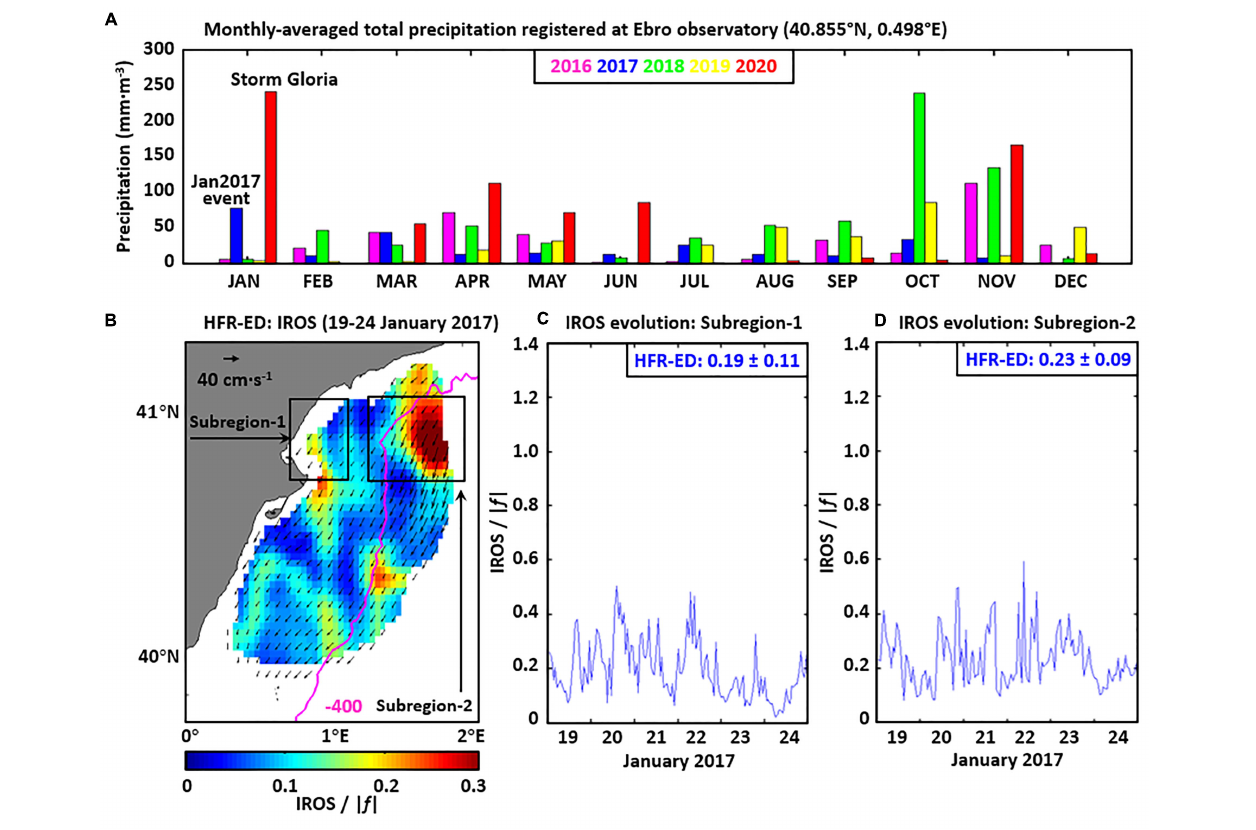
FIGURE 9 | (A) Monthly averaged precipitation registered at the Ebro observatory for the period 2016–2020; (B) Time-averaged map of circulation and Instantaneous Rate of Separation (IROS) for the 6-day period (January 19–24, 2017) as derived from HFR-ED hourly surface currents. (C,D) Temporal evolution of IROS diagnostic, spatially averaged over two different subregions (denoted by black boxes in panel (B) : in the northern periphery of ED mouth (C) and in north-easternmost sector (D)